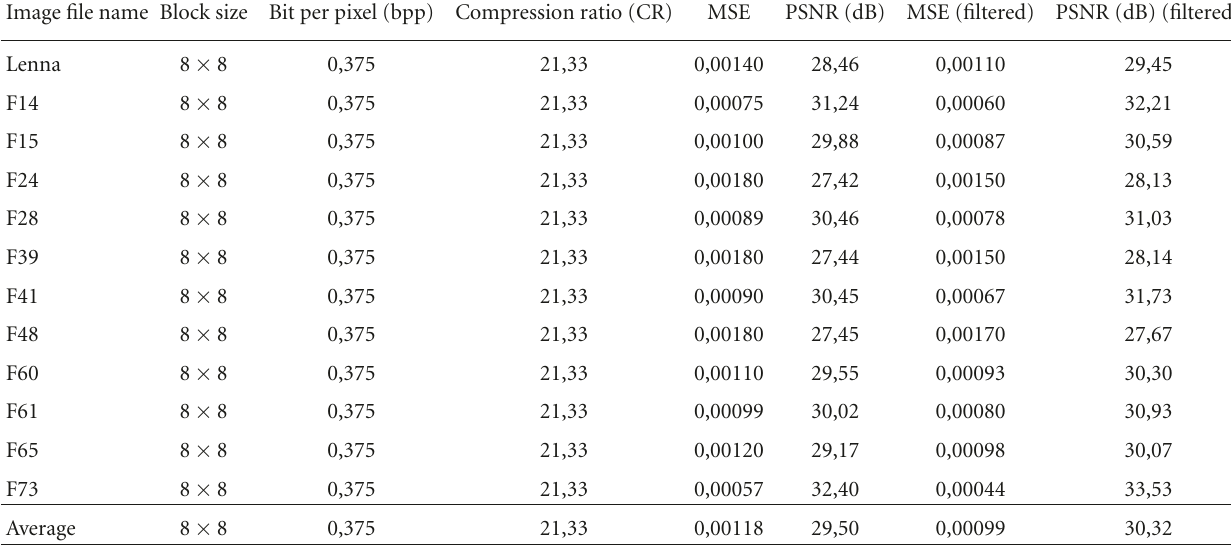
Table 5: Evaluation results of Fold